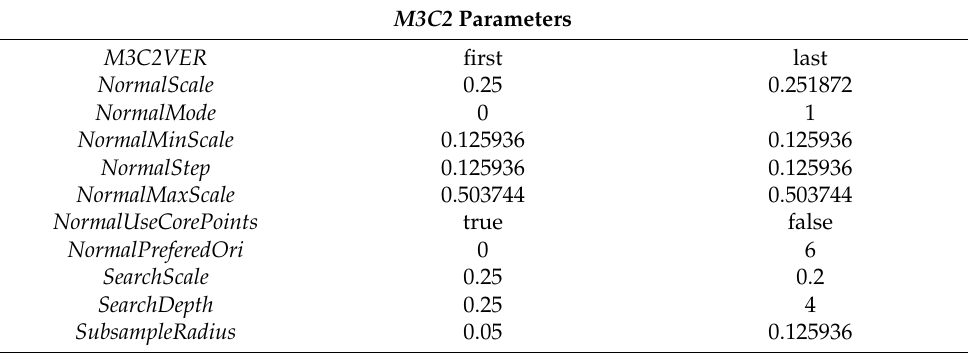
Table 1. Parameters used for running the M3C2 algorithm. The first column shows the parameters suggested by the literature review, while the last column reports the tuned parameters used after some